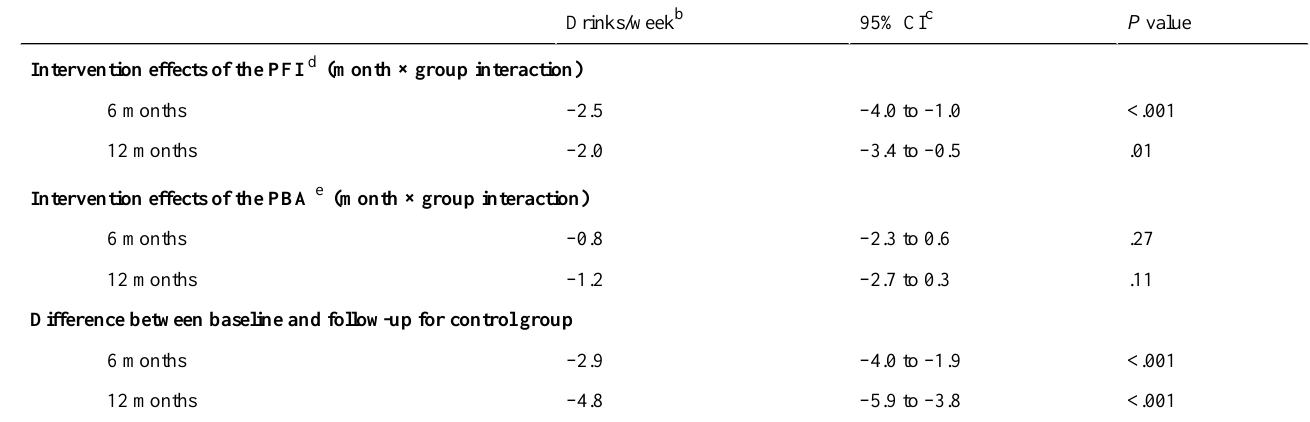
Table 5. Intervention effects on drinks/week based on random intercept model with simple imputation for missing values (last observation carried forward).